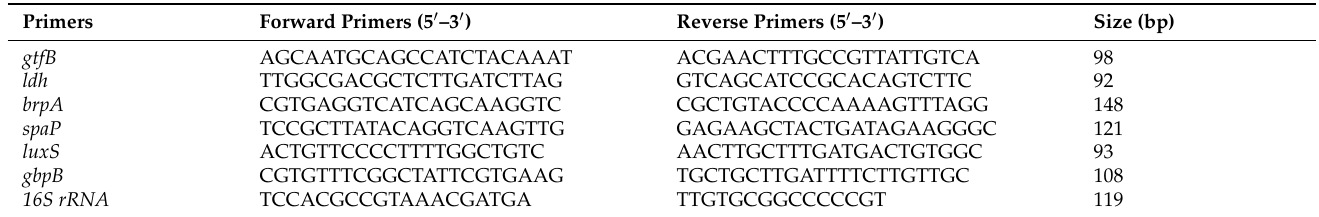
Table 1. Primer sequences for real-time PCR.